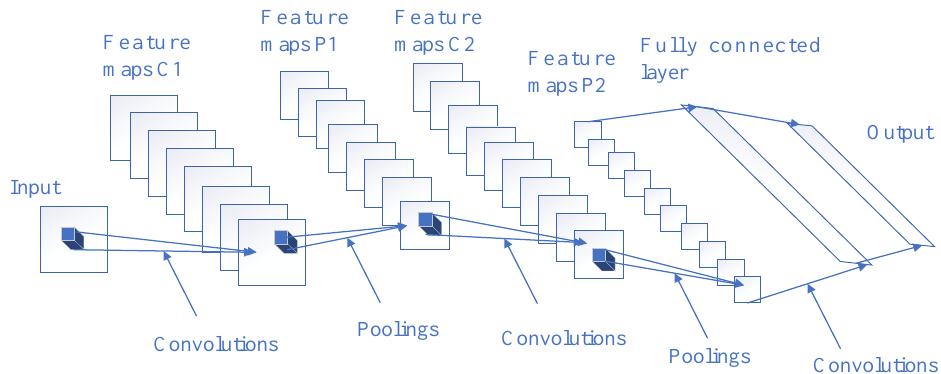
Figure 1. Architecture of a representative convolutional neural network (CNN).